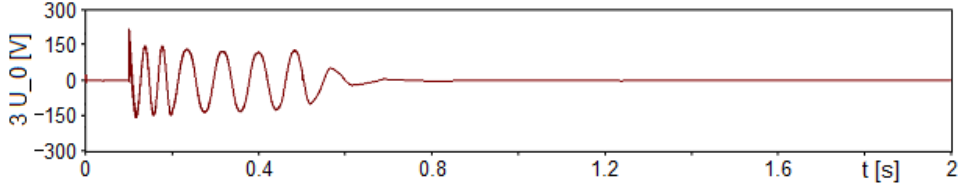
Figure 11. The voltage waveform in the open delta circuit, including the attenuation resistor R_OTD = 10 Ω in the additional winding system.